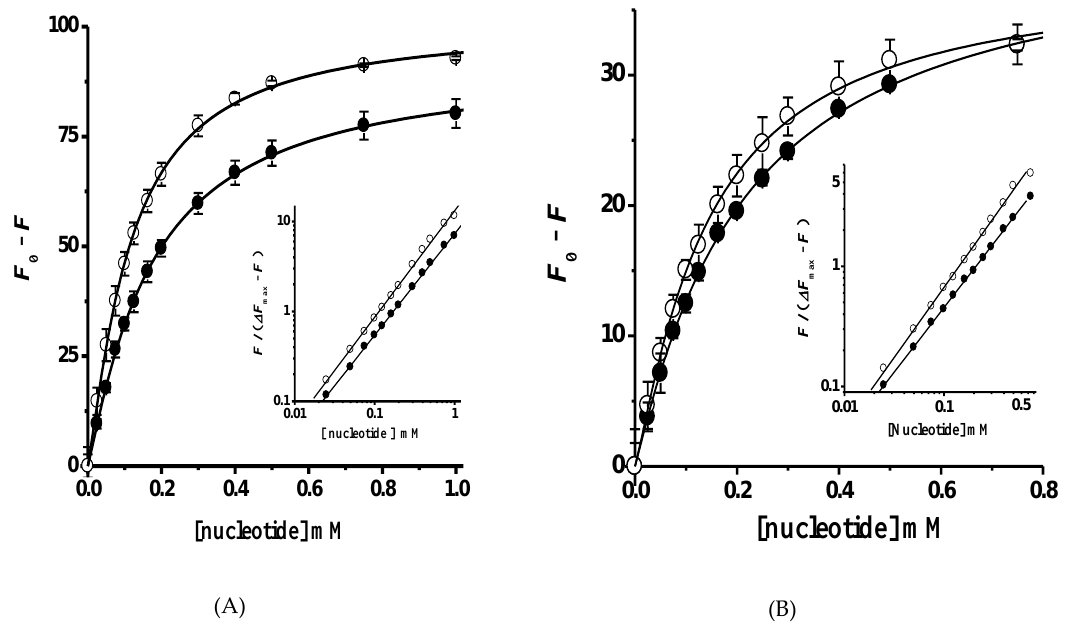
Figure 9. Nucleotide binding in the ( A ) aggregated and ( B ) free H + -ATPase hexamer. The intrinsic fluorescence intensity (Figure 8) of the H + -ATPase at a wavelength ( λ ) of 332 nm in the presence of ( • ) ADP and ( ) AMP-PCP was fitted to Equation 2 by nonlinear regression; the Hill number ( n ) and dissociation constants ( K d ) were calculated: ( A ) n = 1.13 ± 0.02 and 1.20 ± 0.03; K d = 136.0 ± 7.8 and 73.3 ± 5.8 µ M for ADP and AMP-PCP, respectively; ( B ) n = 1.06 ± 0.02 and 1.16 ± 0.04; K d = 190.5 ± 13.9 and 105.8 ± 12.6 µ M for ADP and AMP-PCP, respectively. Insets, Hill plots for nucleotide binding, the slope ( n ) value of the straight lines formed was calculated by linear regression: ( A ) n = 1.12 ± 0.01 and 1.18 ± 0.02 for ADP and AMP-PCP, respectively; ( B ) n = 1.07 ± 0.01 and 1.16 ± 0.01 for ADP and AMP-PCP, respectively. Fluorescence data are the mean ± SD of three experiments.